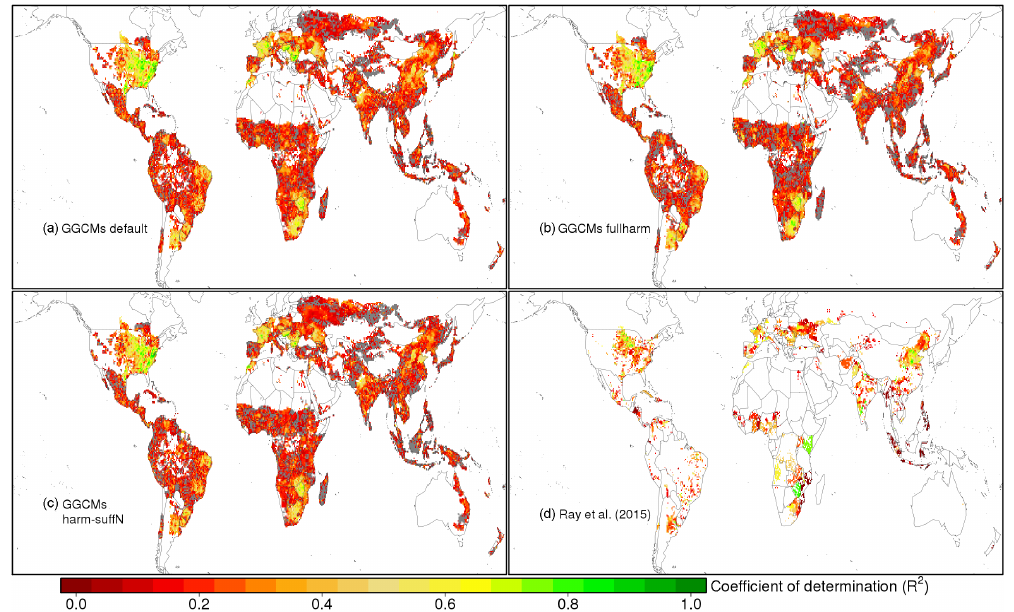
Figure 10. Analysis of time series correlation between the GGCM ensemble simulations for maize (selecting best correlation across the GGCMs per grid cell) and the Ray2012 reference data set after removing trends via a moving average (see methods). Gray areas depict areas where none of the GGCMs find a statistically significant correlation; white areas have no yield data for that crop in Ray2012 data sets. Panel (a) shows coefficients of determination ( R 2 ) for the default setting, (b) for the fullharm setting, (c) for the harm-suffN setting, and (d) shows the original coefficients of determination as reported by Ray et al. (2015) for an ensemble of 27 regression